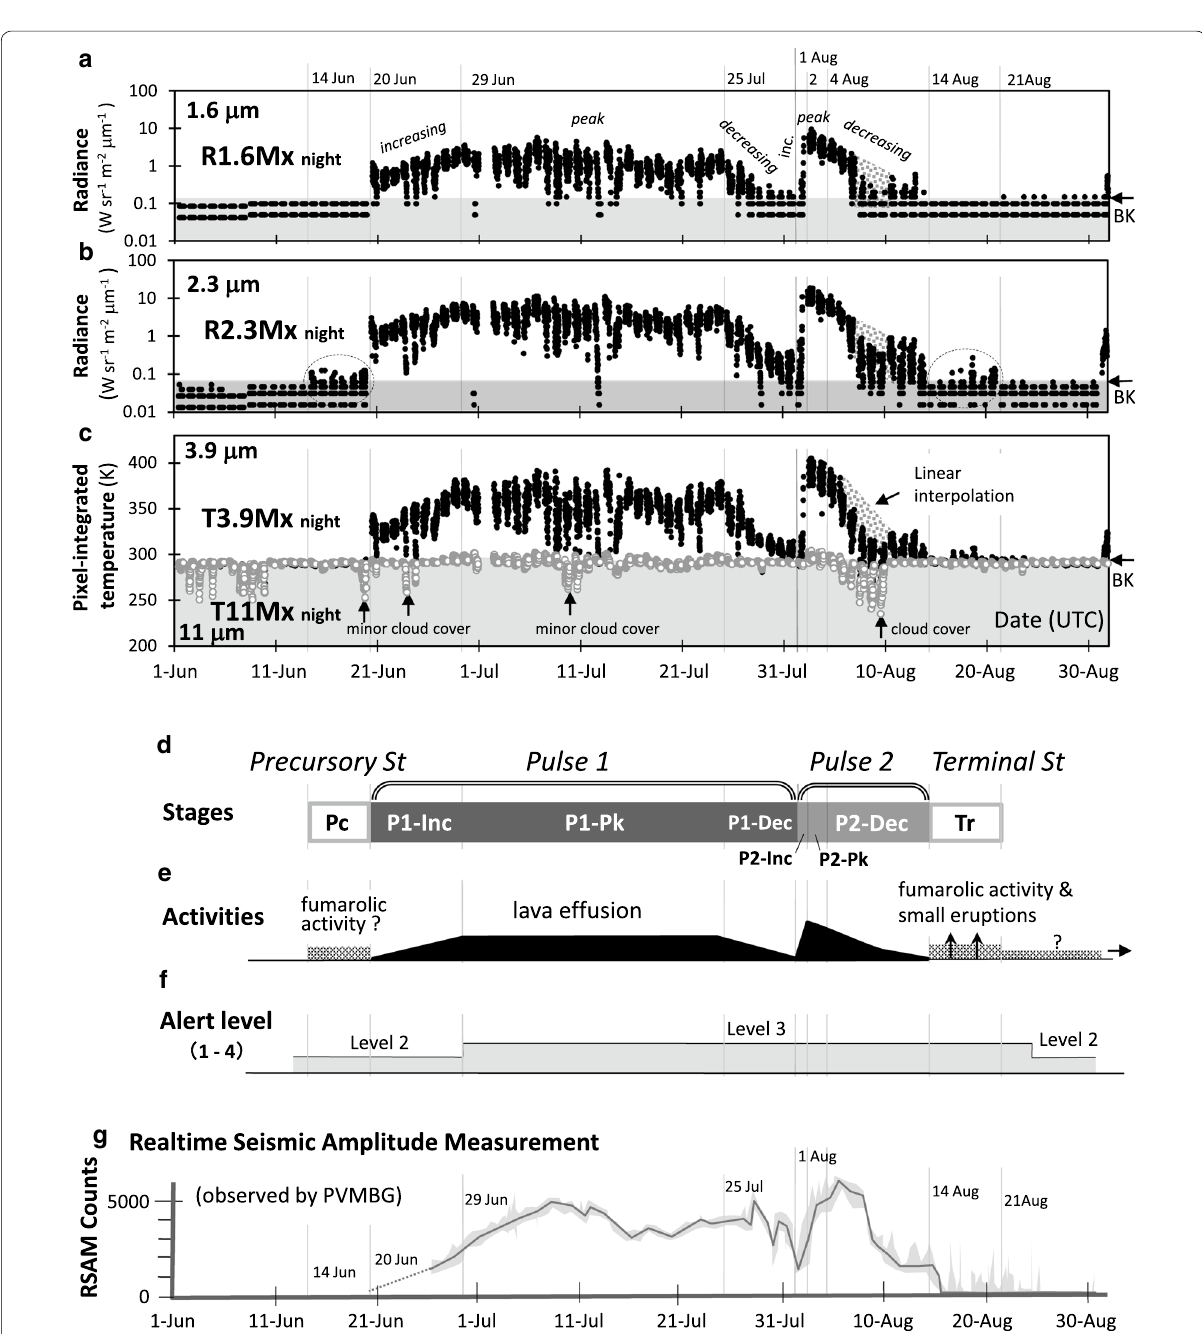
Fig. 4 Results of long-term observations based on nighttime Himawari-8 AHI images, and related information. a Time-series variations in spectral radiance at 1.6 μm (R1.6Mx). b Time-series variations in spectral radiance at 2.3 μm (R2.3Mx). c Time-series variations in pixel-integrated temperatures at 3.9 μm (T3.9Mx) and 11 μm (T11Mx). d Stage segmentation based on time-series variations in thermal anomalies. Pc: precursory stage, Tr: terminal stage, P1: pulse 1, P2: pulse 2, Inc: increasing period, Pk: peak period, Dec: decreasing period. e Variations in activity mode. f Alert levels issued by PVMBG. g Time-series variations in seismic activity (10-min RSAM count) observed by Pusat Vulkanologi dan Mitigasi Bencana Geologi (2016). The original plot has been reproduced and